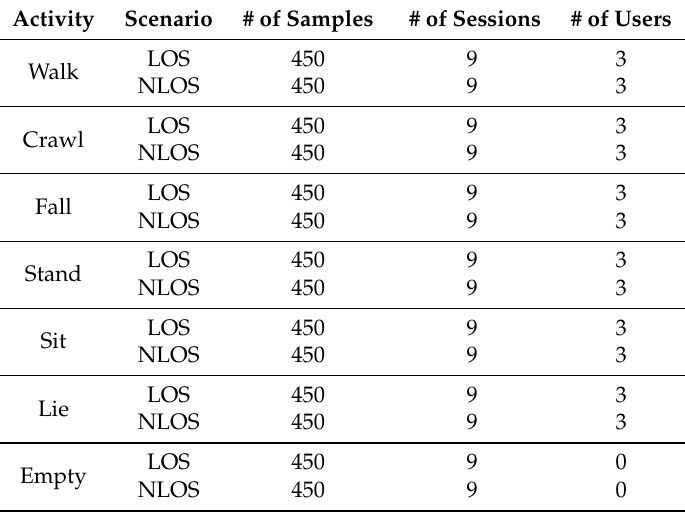
Table 1. Collected sample details, Line-of-Sight (LOS); Non-Line-of-Sight